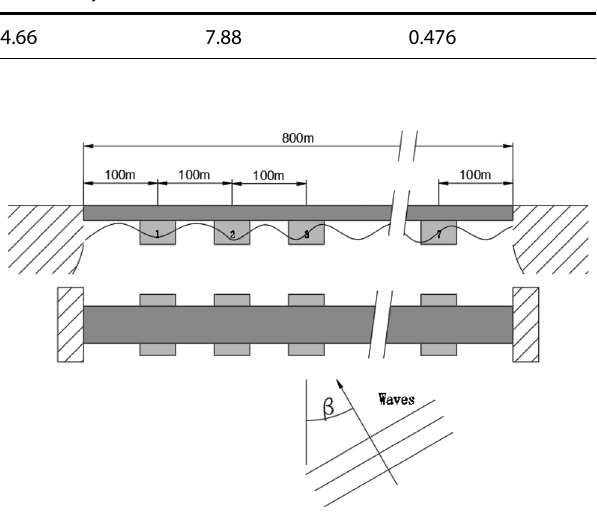
Fig. 2 The simplified calculation model of the Norwegian Berg- søysund bridge applied in Ref